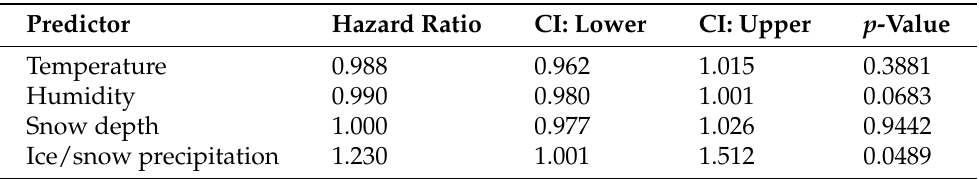
Table 5. Hazard ratios from punctual to delayed states.